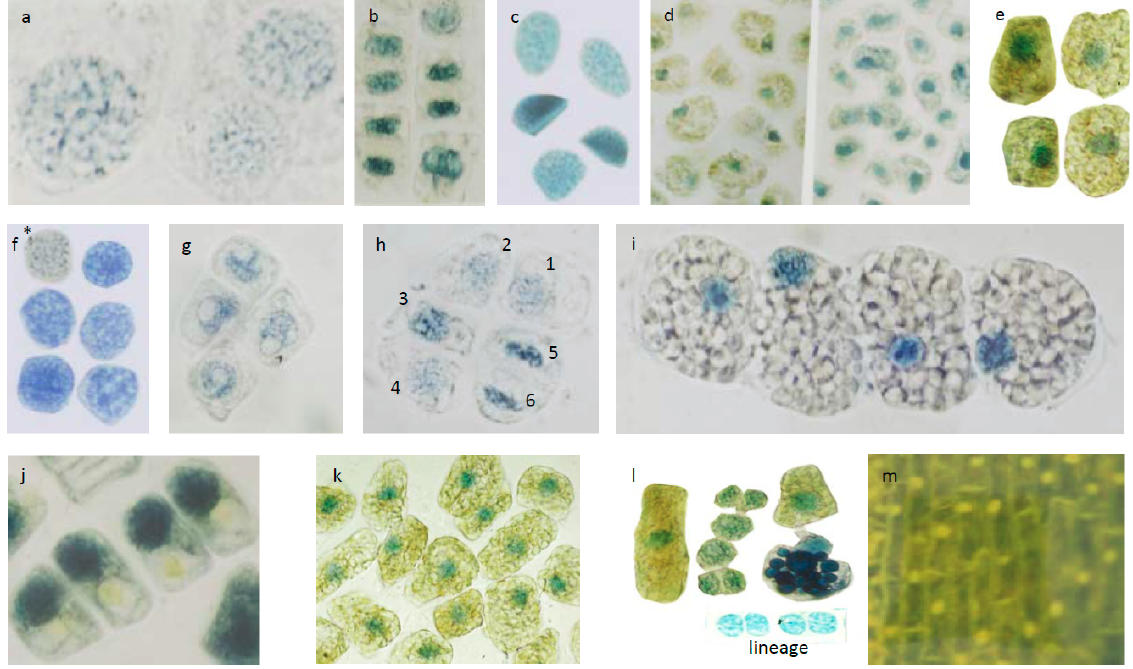
Figure 4. Nuclear flavanols as blue and, if combined with flavonols, as greenish clusters of the Tsuga and Taxus